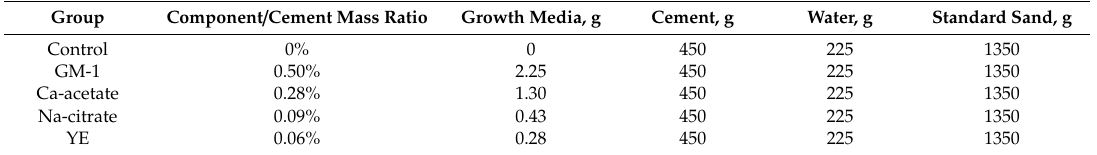
Table 3. Mix proportions for each